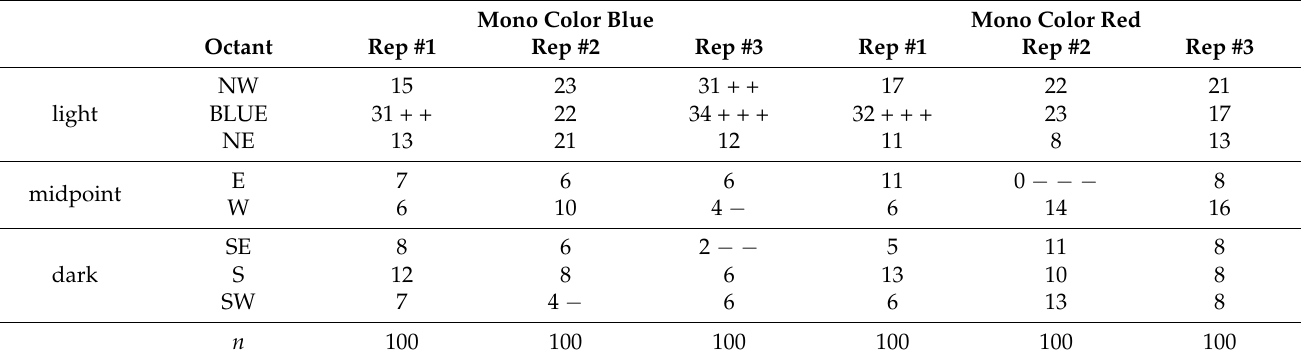
Table 6. Movements of beetles to octants. Experiment #3. Mono color blue. Coding as –: p ≤